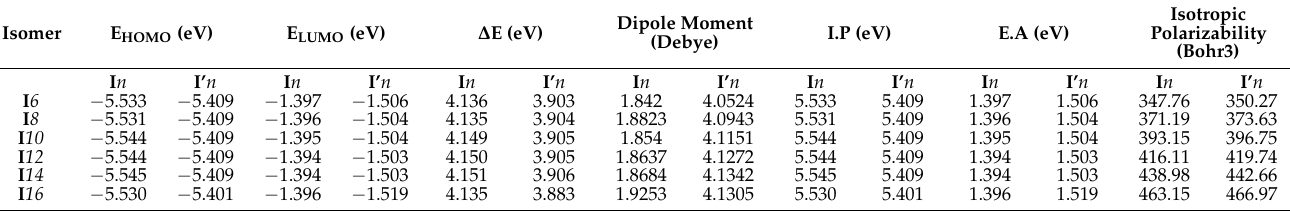
Table 3. Reactivity parameters calculated at